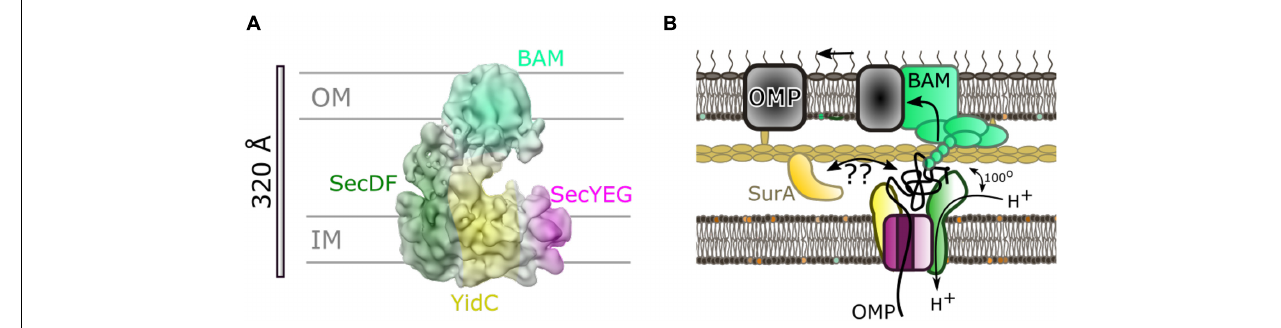
FIGURE 7 | Inter-membrane association of HTL and BAM. (A) 14 Å cryo-EM density from Alvira et al. (2020) colored to show locations of BAM (light green) and components of HTL: SecDF (dark green), SecYEG (magenta) and YidC (yellow). (B) Cartoon of model for translocation through the HTL-BAM inter-membrane complex adapted from Alvira et al. (2020). Movement of periplasmic domains of SecDF (dark green) has a role in energy transduction of the PMF to the BAM complex for OMP maturation. The precise nature of the involvement of periplasmic chaperones is unknown; SurA is known to interact with OMPs soon after emergence from SecY and also with BAM on the other side of the